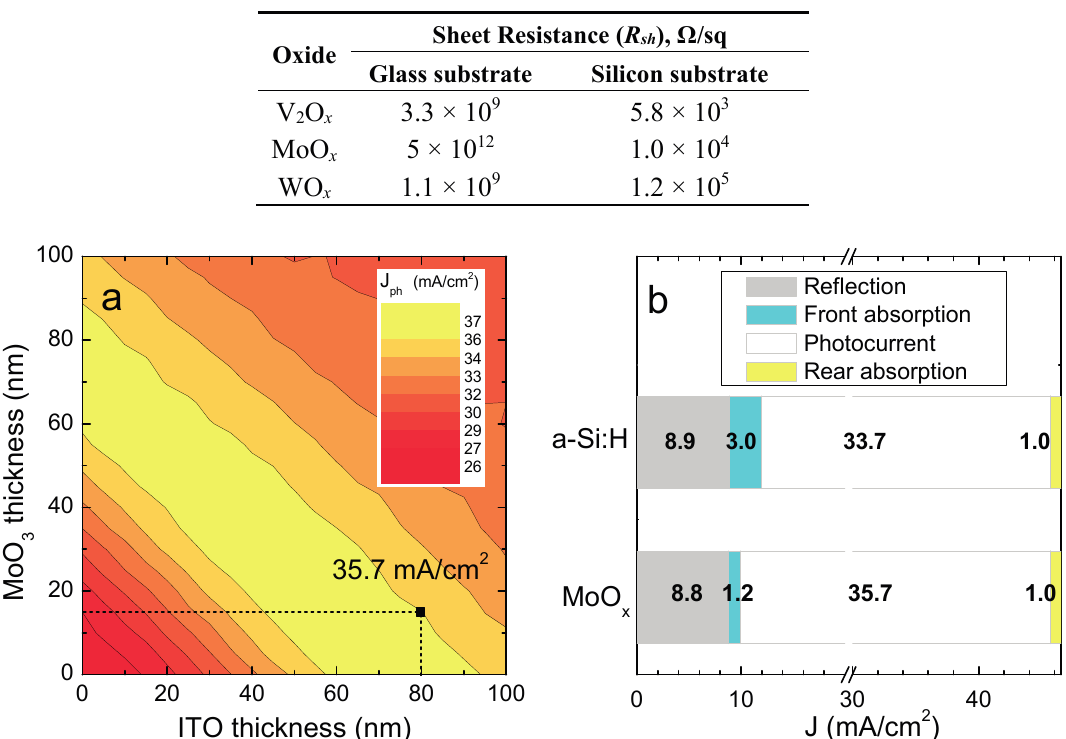
Table 1. Sheet resistance ( R ) of the oxides calculated from the transfer length method sh (TLM). The ReO 3 device was not measured due to film instabilities.